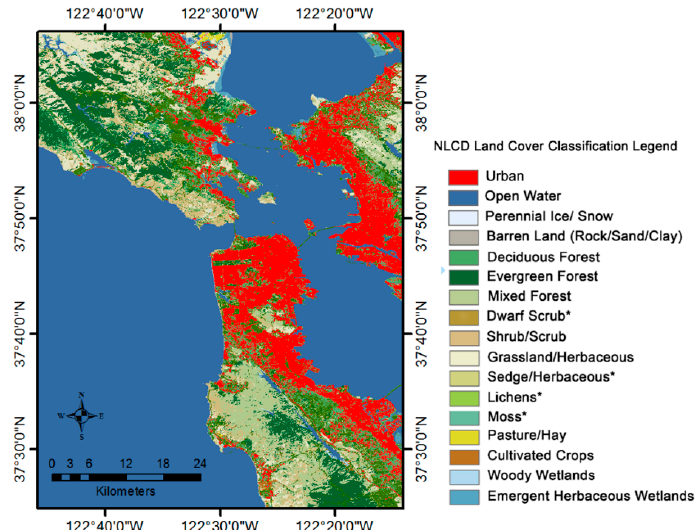
Figure 3. Ground reference image (NLCD 2006 land cover 30 m) with seventeen